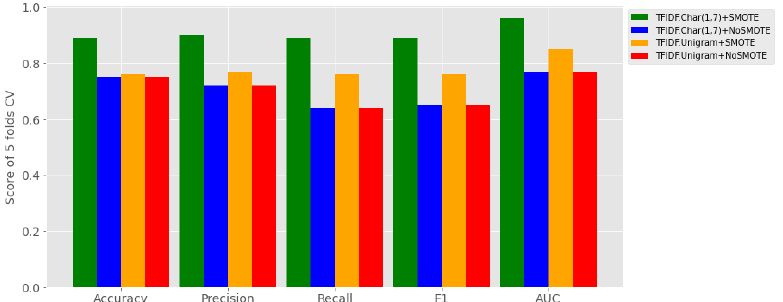
Figure 4. Comparison of the Performance of Proposed Stacking Sentiment Classifier using differ‑ ent features (TF‑IDF character (1,7) grams + with(no) SMOTE) and (TF‑IDF uni‑grams + with(no) SMOTE) using all four data sets.